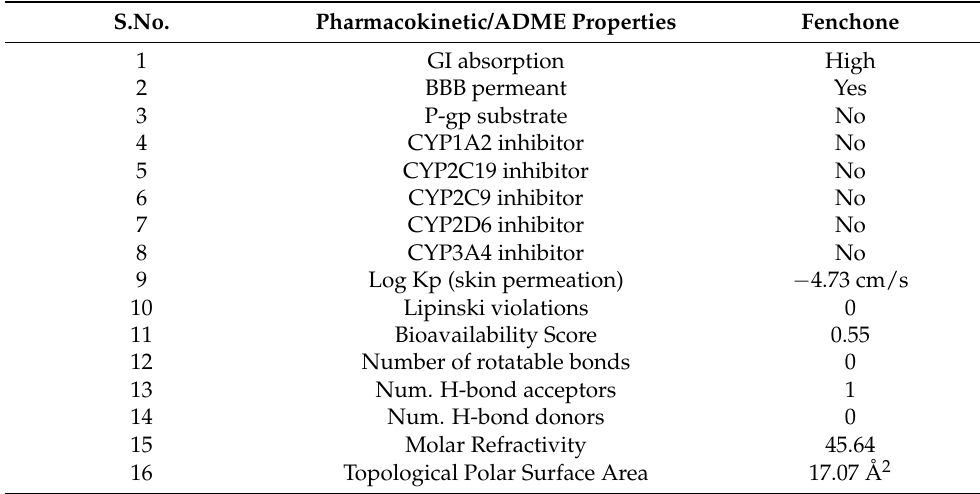
Table 1. Pharmacokinetic properties and physicochemical characteristics of Fenchone.